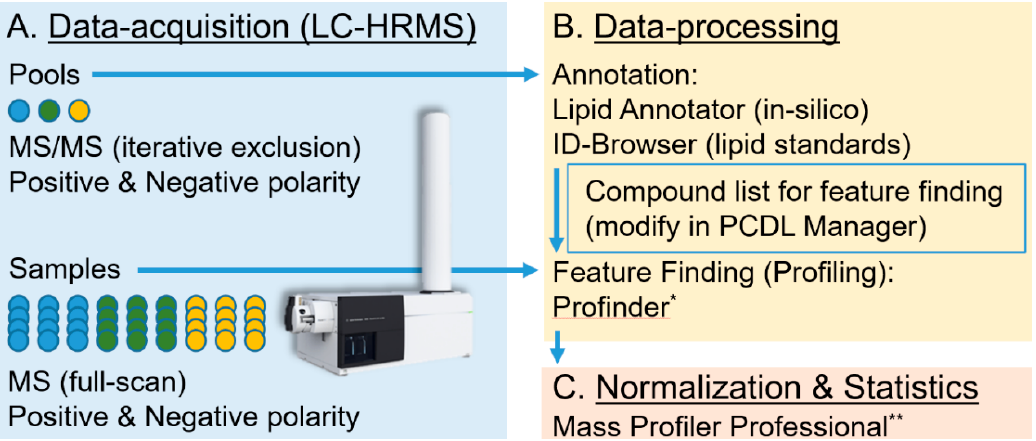
Figure 1. Example of a lipidomics workflow employing Lipid Annotator. MS/MS can be acquired on only a few representative samples saving acquisition and processing time ( A ). Note that iterative exclusion MS/MS of various pools from different groups (e.g., healthy, disease, and control) can be imported into a single Lipid Annotator project, or all groups can be pooled and analyzed via Lipid Annotator. Resulting data is imported into Lipid Annotator (and optionally ID-Browser) to